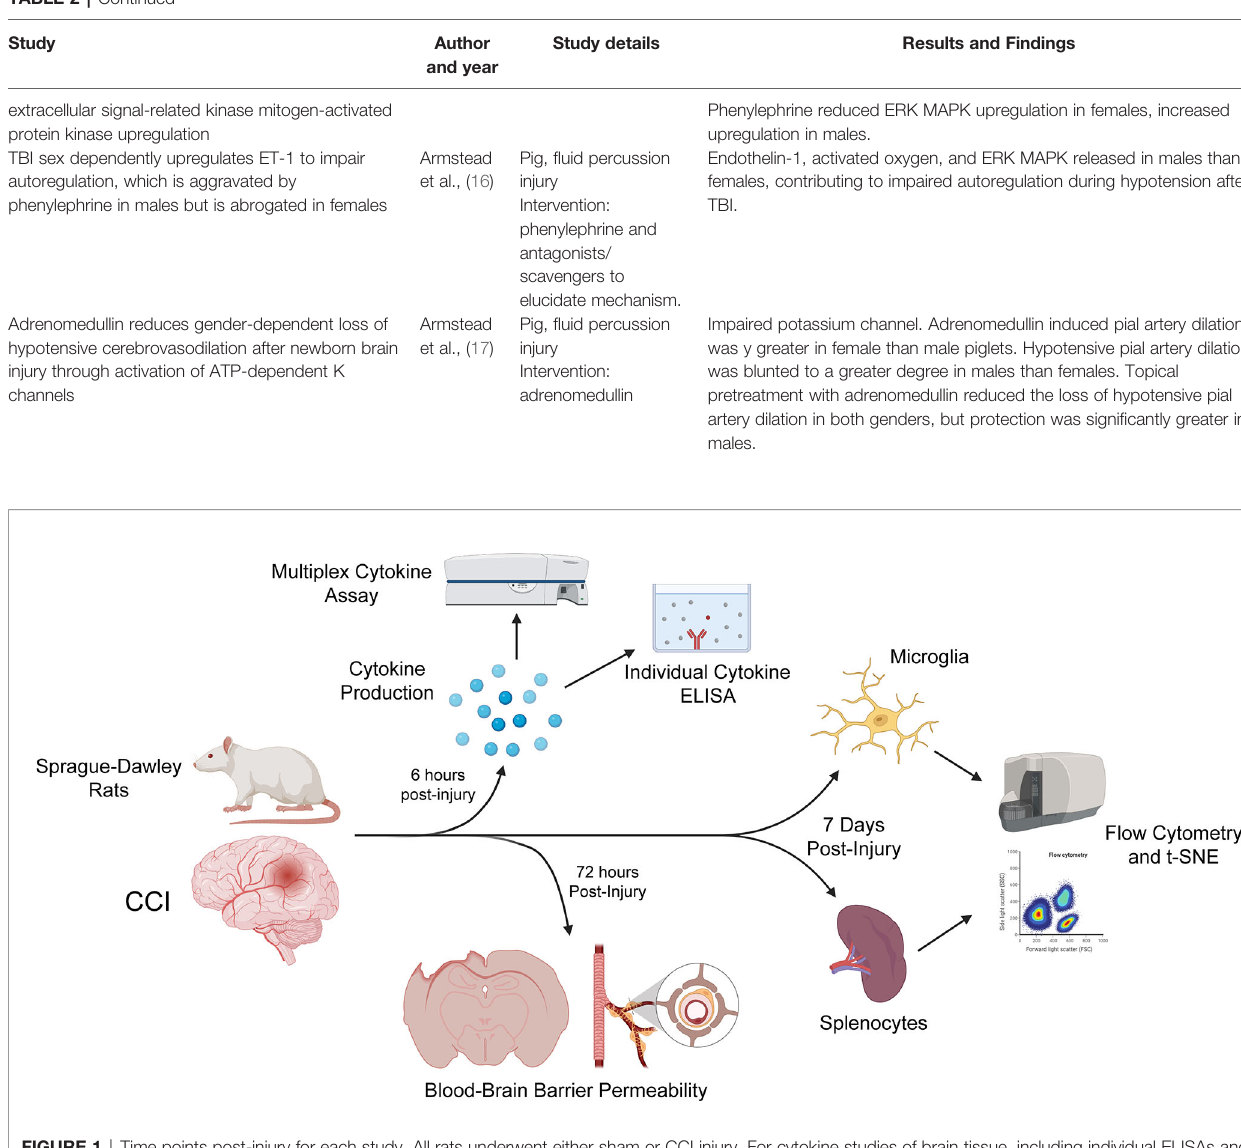
FIGURE 1 | Time points post-injury for each study. All rats underwent either sham or CCI injury. For cytokine studies of brain tissue, including individual ELISAs and a multiplex cytokine assay (performed using the LSR-II fl ow cytometer [BD Bioscience]), rats were sacri fi ced 6 hours after injury, to capture the peak of cytokine production. Rats were sacri fi ced 72 hours post-injury for our assessment of blood-brain barrier permeability. Flow cytometry and t-SNE of microglia and splenocyte immunophenotype using the Beckman-Coulter Gallios fl ow cytometer was performed 7 days after injury. Created with